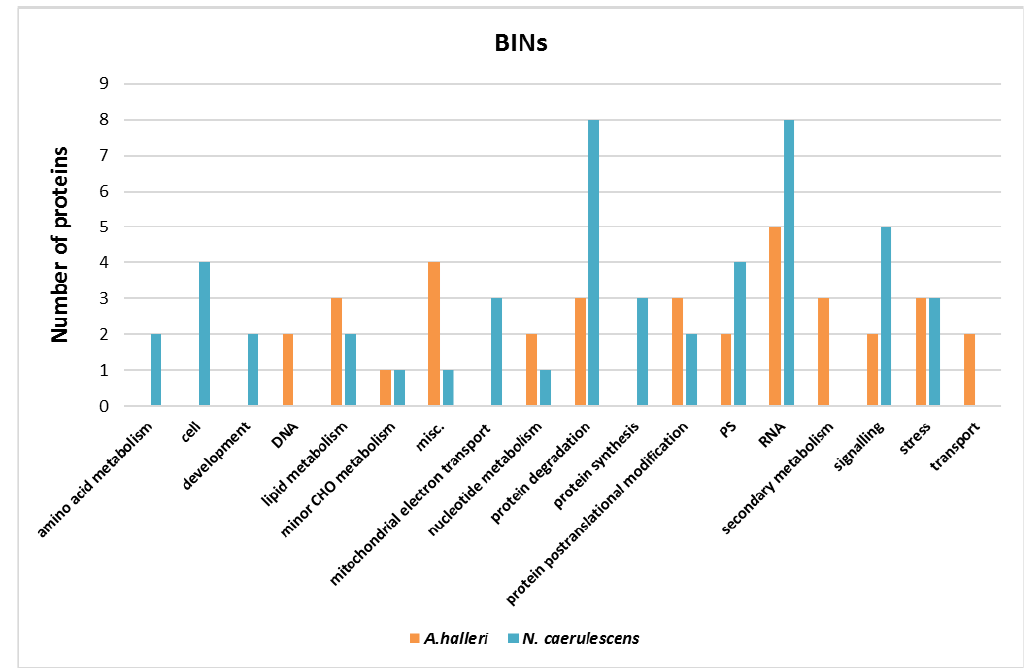
Figure 7. Responsive proteins according to MapMan ontology. The distribution of responsive proteins in A. halleri (in blue) and of N. caerulescens (in orange) according to MapMan ontology classification (BINs). On the x axis there are the different MapMan bin types, and on the y axis there are the number of proteins for each bin. The data reported are for the nano and ion forms of both metals pooled together for the two plant species.